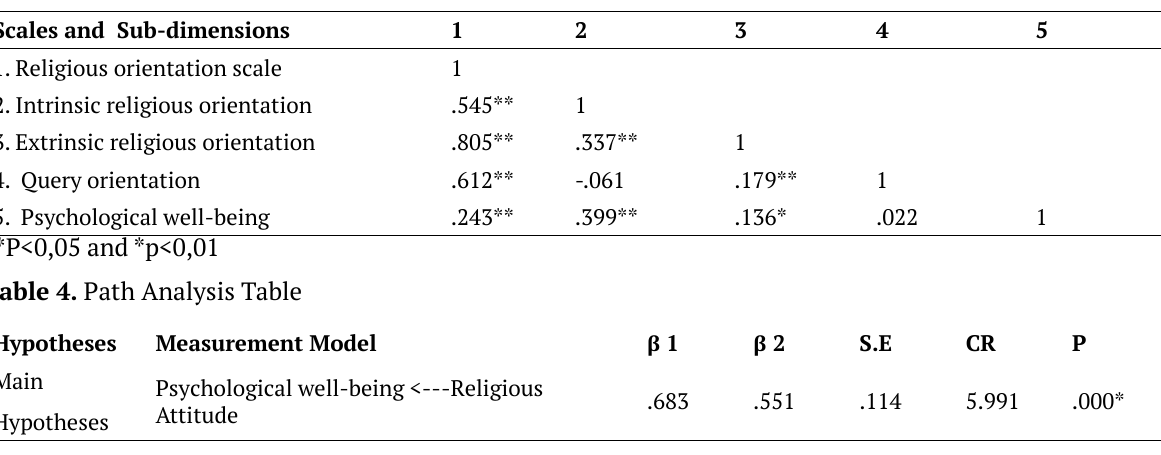
Table 5. Mediator variable analysis to determine the effect of religious orientation on psychological